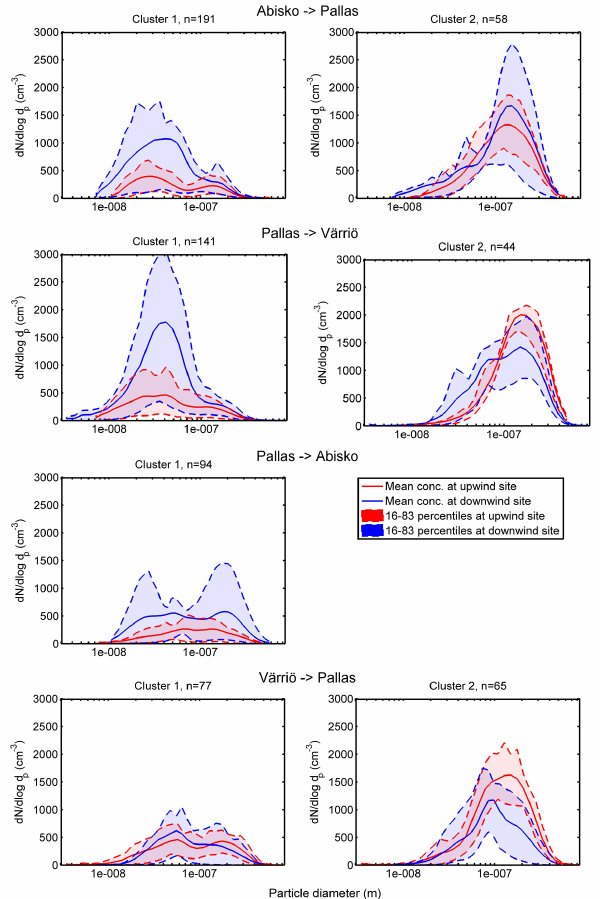
Fig. 9. The dynamics of the particle number size distributions when air masses were moving from one measurement site to another. Summer season 1.4.–30.9 covered. The initial size distributions at the upwind station were clustered to obtain as similar initial states as possible. Each subplot represents one cluster. The first member of the site pair is the upwind site, and the second member is the downwind site. For each cluster, the mean number size distribution at the upwind station is plotted with solid red line, and the shad- owed red area shows the 16–83th percentiles. Similarly, the blue solid line is the mean of the corresponding size distributions at the downwind station, and shaded blue area shows the above-mentioned percentiles. The number n shows the amount of size distribution pairs in each cluster.